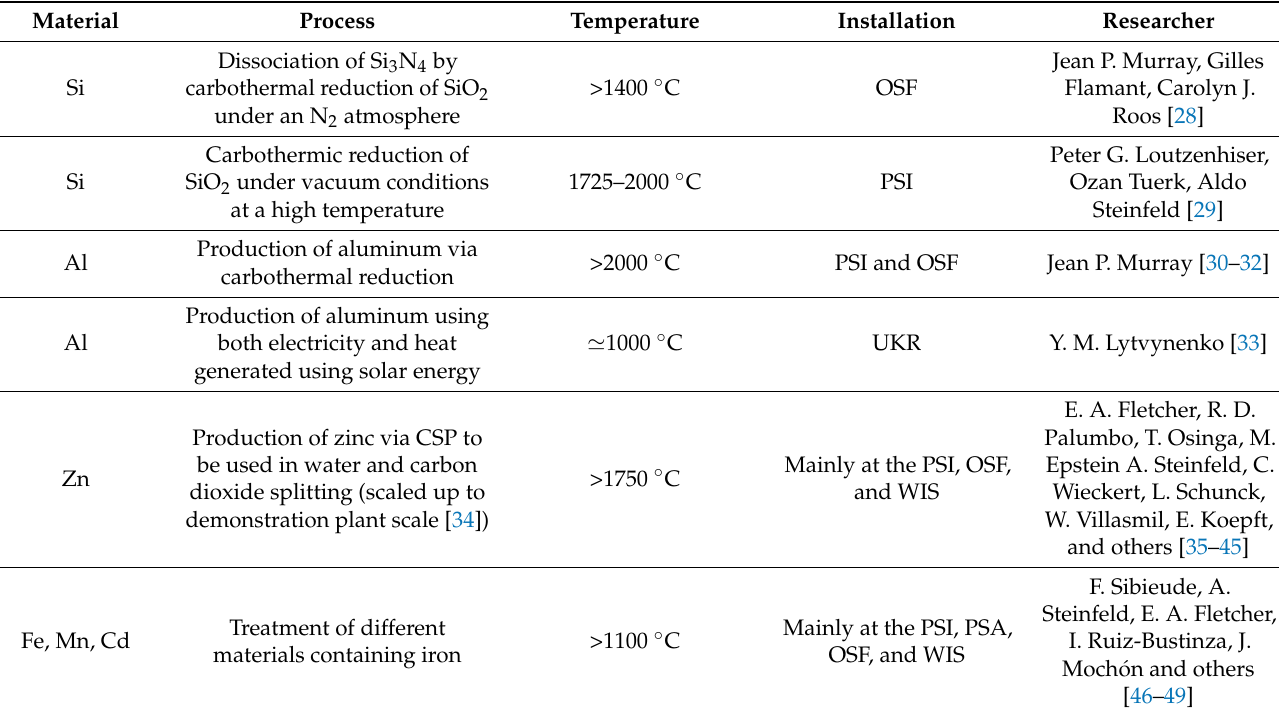
Table 1. Main types of research in the field of metallurgy and mineral processing using CSP (abbreviations: OSF, Odeillo Solar Furnace; PSI, Paul Scherrer Institute; WIS, Weizmann Institute of Science; UKR, Institute for Problems of Materials Science of NAS of Ukraine; PSA, Plataforma Solar de Almer í